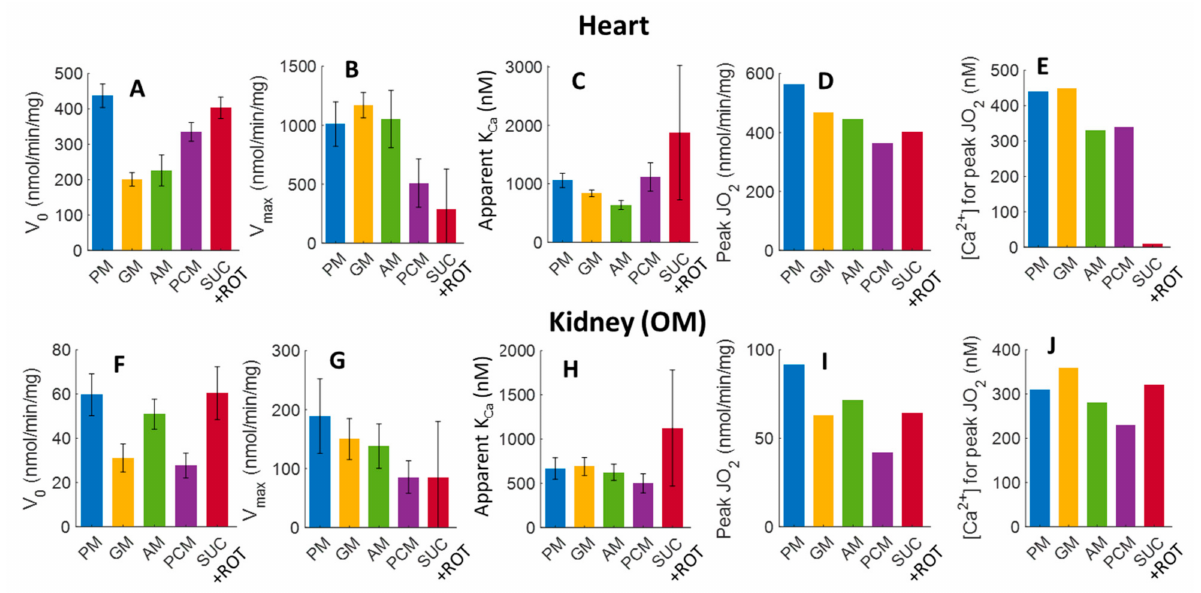
Figure 9. Estimated values of V 0 , V max , apparent K Ca , peak Ca 2+ stimulated state 3 JO 2 , and [Ca 2+ ] free required for achieving the peak Ca 2+ stimulated state 3 JO 2 , and their corresponding 95% confidence intervals obtained based on the nonlinear regression (fitting) of Equation (1) and the state 3 JO 2 data from Figure 5. Bar plots in the upper panels ( A – E ) and bottom panels ( F – J ) represent the parameters for the heart and kidney OM mitochondria, respectively, for different respiratory substrates (PM, GM, AM, PCM, and SUC + ROT). The peak Ca 2+ stimulated state 3 JO 2 ( D , I ) and [Ca 2+ ] free required for achieving the Ca 2+ peak stimulated state 3 JO 2 ( E , J ) for each substrate and tissue was predicted by the